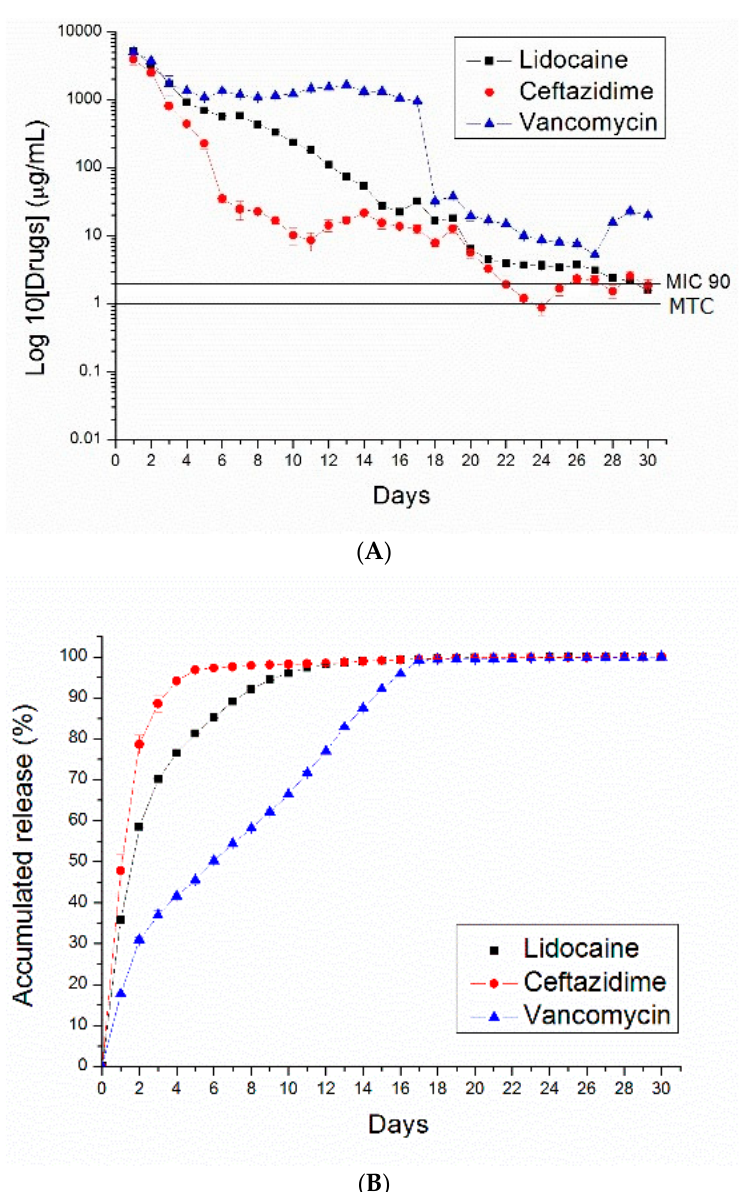
Figure 10. PLGA (50:50)—( A ) daily and ( B ) accumulated release curves of pharmaceuticals from 400 mg PLGA nano/microparticle-loaded buffered solution.